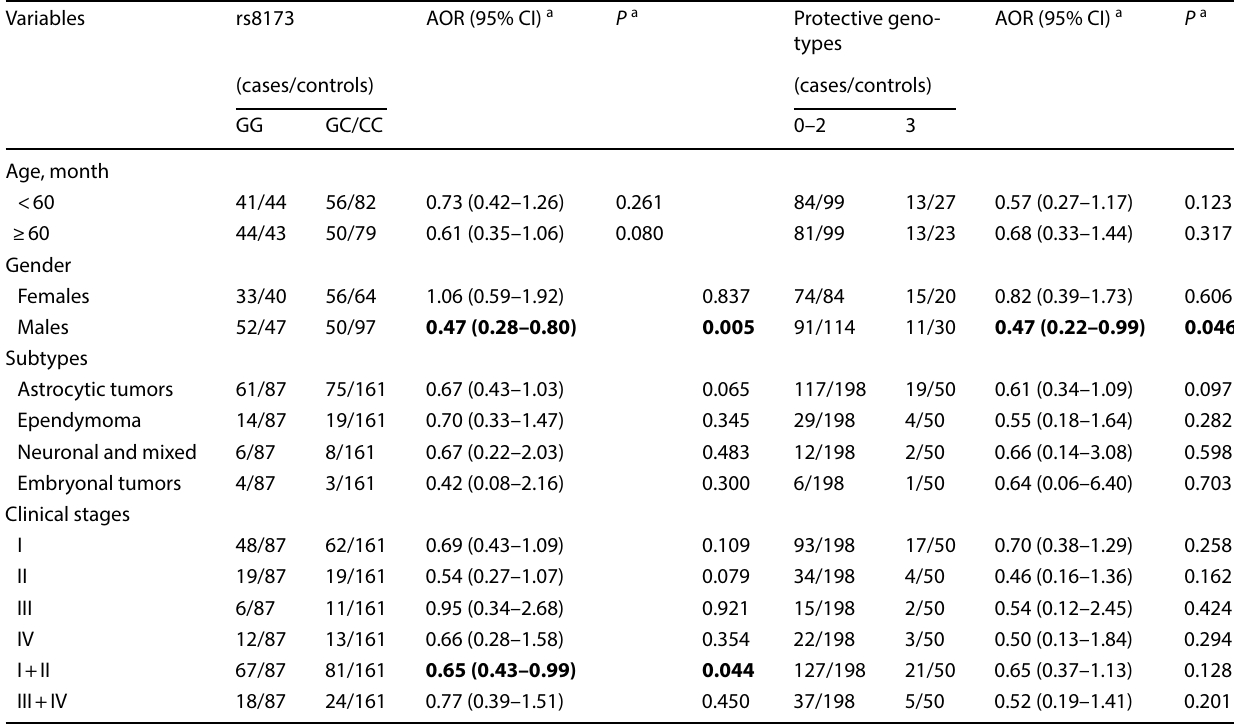
Table 2 Stratification analysis of risk genotypes with CNS tumor